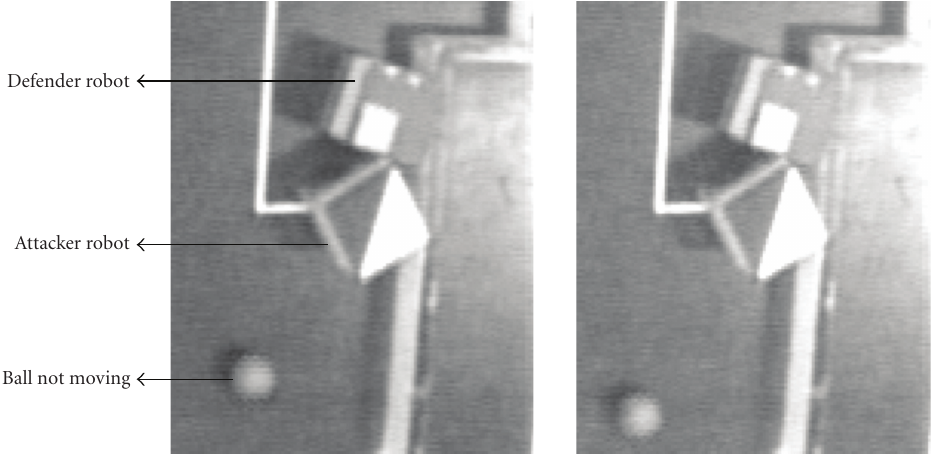
Figure 16: A stalemate